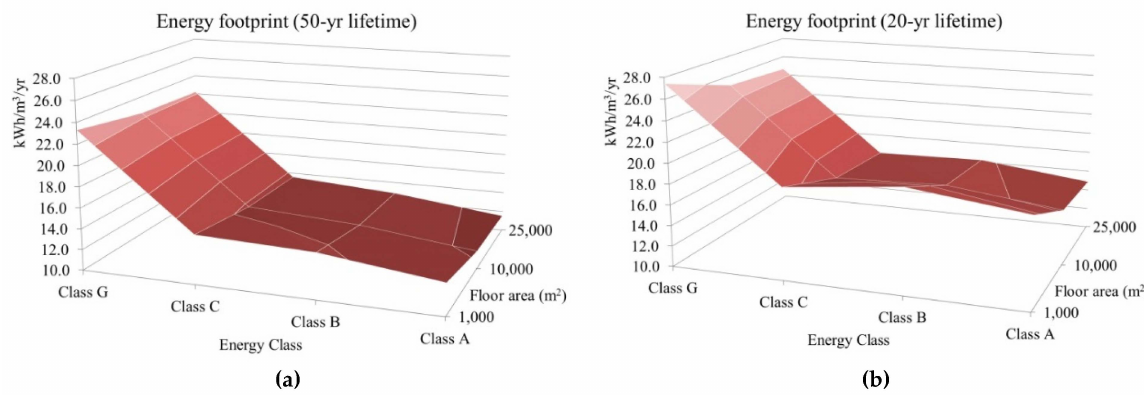
Figure 12. EF as a function of floor area and insulation level under reference hypotheses. Results (kWh/m 3 /year) are shown for 50-year lifetime ( a ) and 20-year lifetime ( b